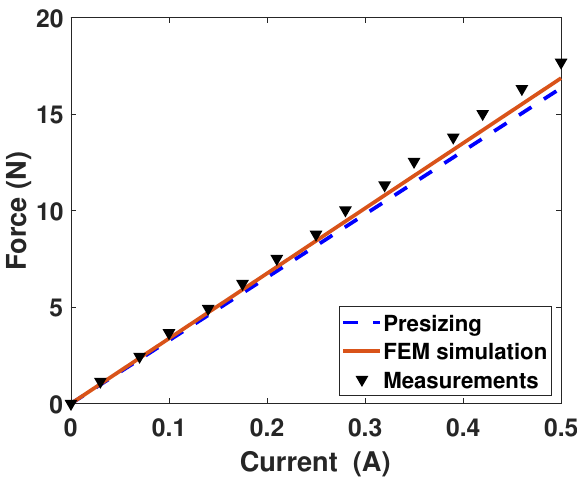
Figure 15. Force-current relation: the slope corresponds to K f